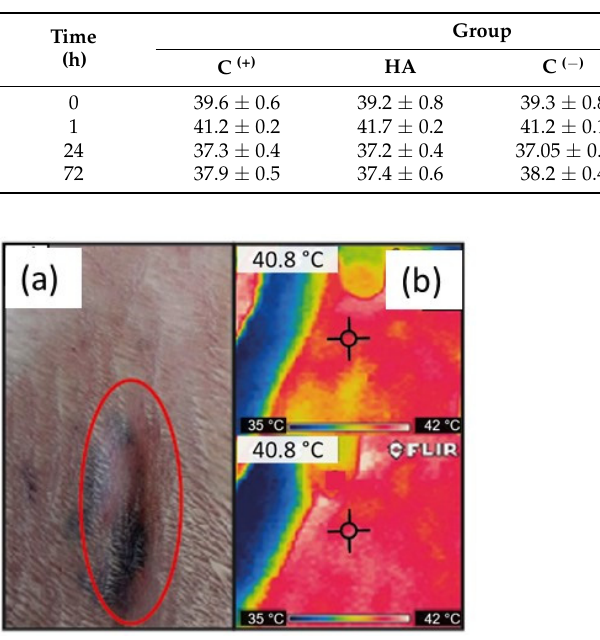
Table 3. Determination of the thermal profile of the intradermal inoculation sites.